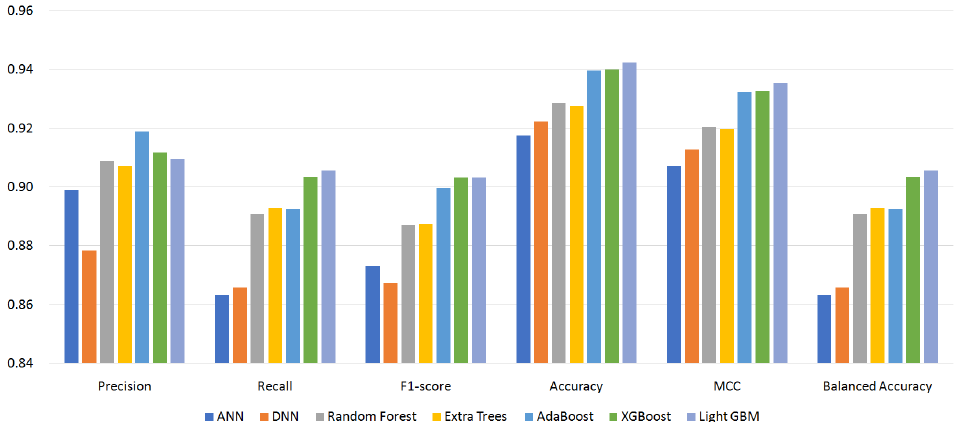
Figure 6. Performance of classifiers with permission set S64.